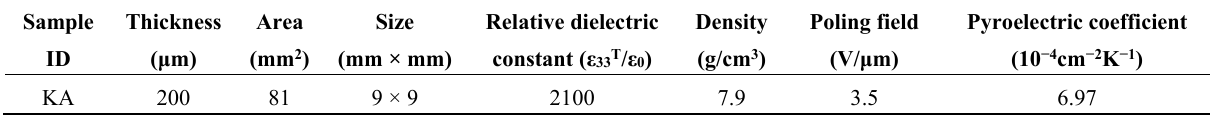
Table 1. Properties of the commercial PZT pyroelectric